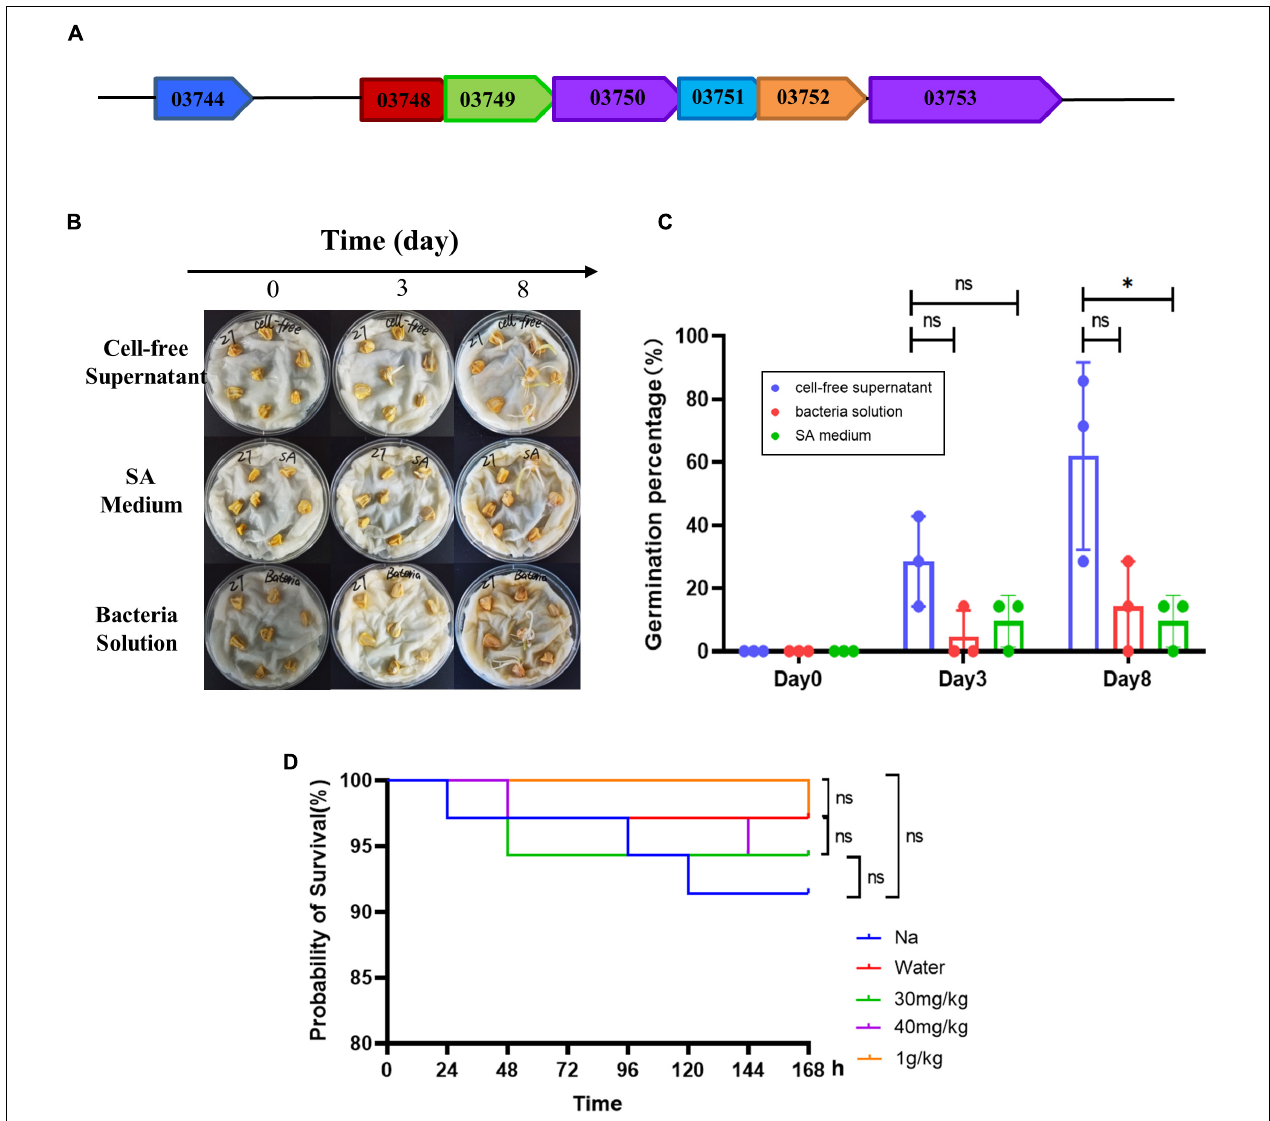
FIGURE 8 | Gene prediction, maize germination, and toxicity assessment. (A) Prediction of genes related to siderophore synthesis in AS19. The arrow direction indicates the direction of transcription. The overlapped of arrows indicates the base sequence of overlap. (B) The germination of maize seeds treated with CFS and the bacterial solution of AS19. The SA medium group was the control group. (C) The germination percentage of maize seeds (a total of seven in each group). The experiment was repeated three times. Three dots represent the germination percentage of three experiments (ns, no significant difference, ∗ p < 0.05). (D) Toxicity test of Hermetia illucens L. larvae. Improved survival rate of H. illucens L. larvae with CFS. H. illucens L. larvae were randomly divided into five groups. The natural growth (NG) group was only punctured. The control (Control) group was injected with 2.5 µ L of sterile saline. The experimental group was injected with 2.5 µ L